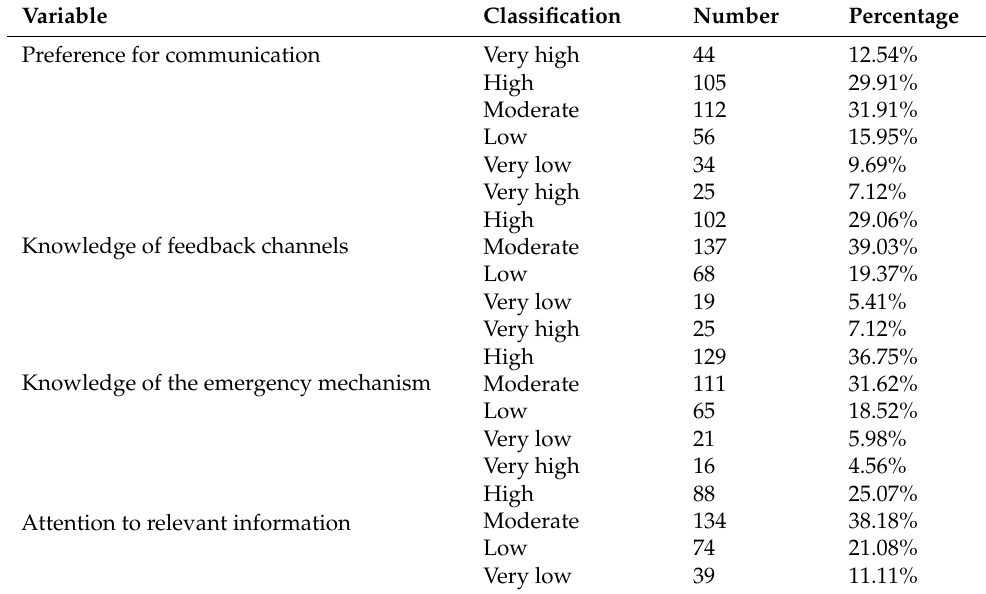
Table 4. Information communication of